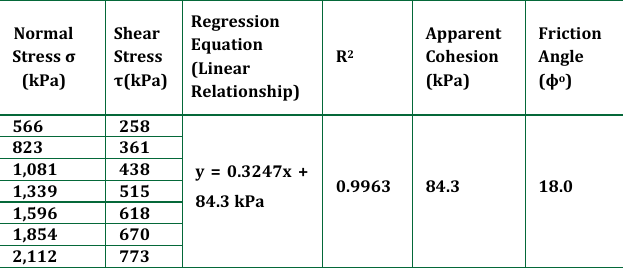
Figure 3: Horizontal displacement versus shear stress for polished